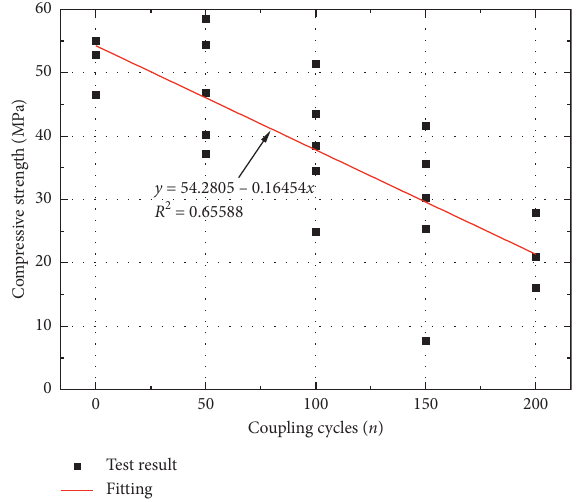
Figure 7: The relationship between compressive strength and coupling